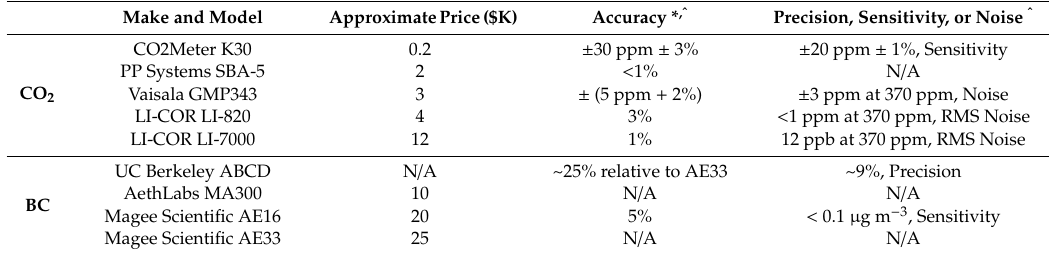
Table 1. Black carbon (BC) and carbon dioxide (CO 2 ) sensors used in this study, their approximate price ($K USD), and manufacturer-specified performance